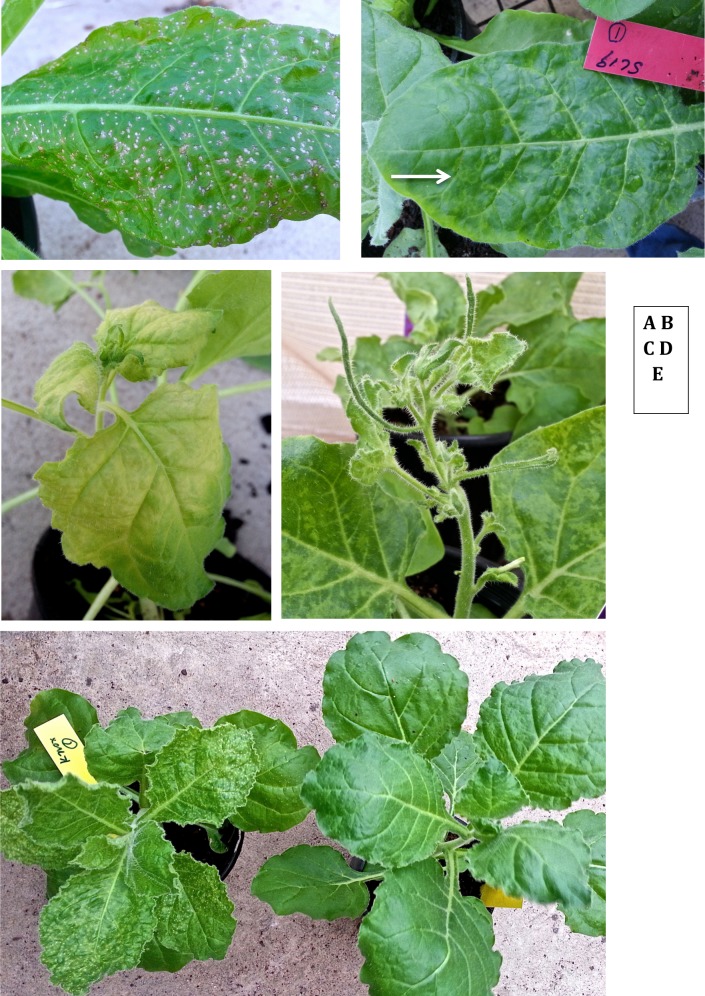
Symptoms of infection.A. Leaf of N. occidentalis ssp hesperis Nt-5 infected with BYMV exhibiting small necrotic lesions within 7 days of infection. B. N. simulans SL19 exhibited small chlorotic rings (arrow) 15 dpi with BYMV. C. Symptoms of infection of YTMMV on N. benthamiana RA-4 20 dpi. D. N. benthamiana VL552B2.1 exhibiting symptoms of leaf mottling and deformation 20 dpi with YTMMV. E. N. benthamiana Kx-1 (left) exhibiting chlorotic spots 20 dpi with BYMV. Plant on the right is uninfected.